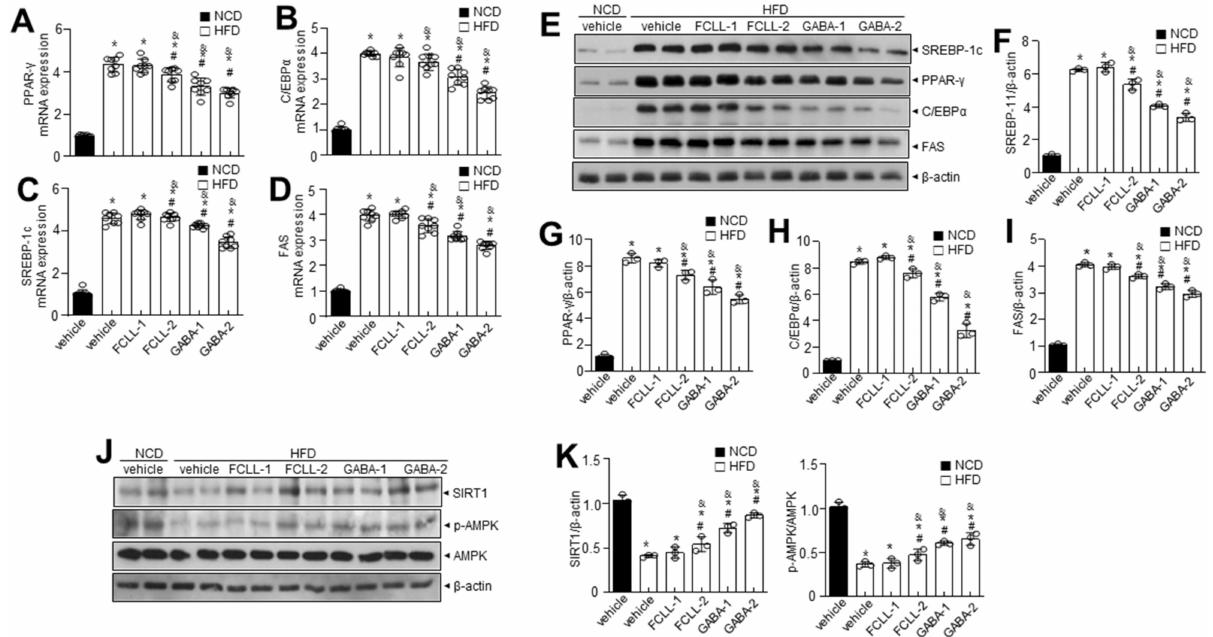
Figure 5. GABA and fermented Curcuma longa L. extract enriched with GABA regulates adipogenesis- related genes in the liver of HFD induced obese mice. Mice were fed with NCD or HFD with vehicle or GABA and GABA-enriched Curcuma longa L. extract (1 or 2 g/kg) once daily for 14 weeks by oral gavage. ( A – D ) PPAR- γ , C/EBP α , SREBP-1c, and FAS were measured in liver tissue by qRT-PCR. ( E ) Immunoblotting of SREBP-1c, PPAR- γ , C/EBP α , FAS, and β -actin expressions in liver tissue and ( F – I ) respective quantitative analysis of protein expressions. ( J ) Immunoblotting of SIRT-1,